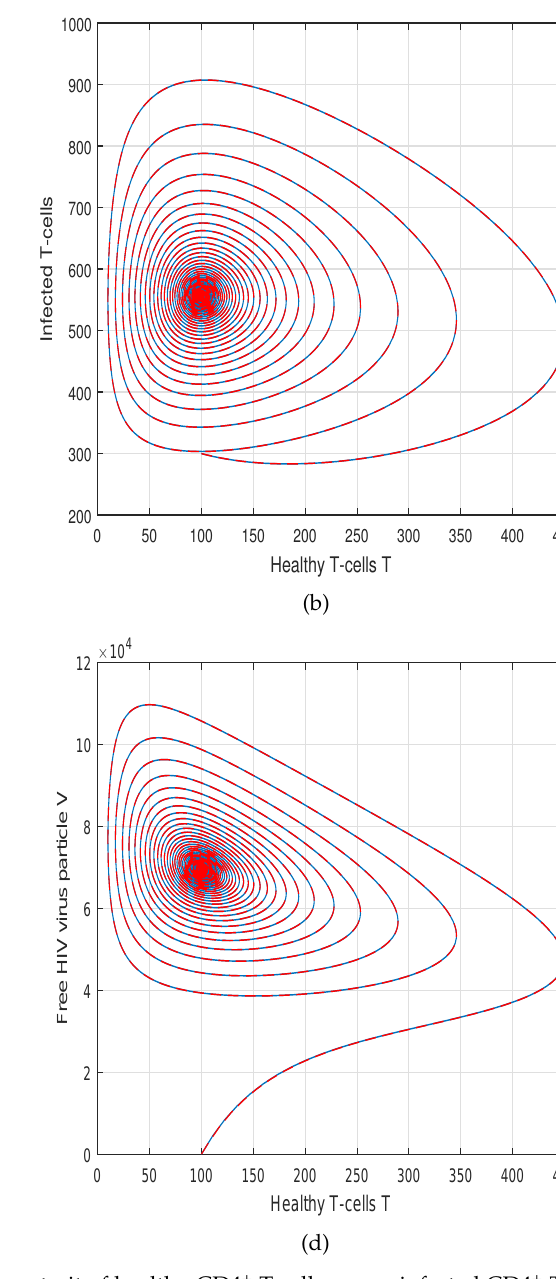
Figure 5. Illustration of the ( a ) chaotic behavior, ( b ) phase portrait of healthy CD4 + T-cells verses infected CD4 + T-cells, ( c ) phase portrait of infected CD4 + T-cells verses free HIV virus particles and ( d ) phase portrait of healthy CD4 + T-cells verses free HIV virus particles of the fractional model (2) of HIV infection with fractional-order ϑ =